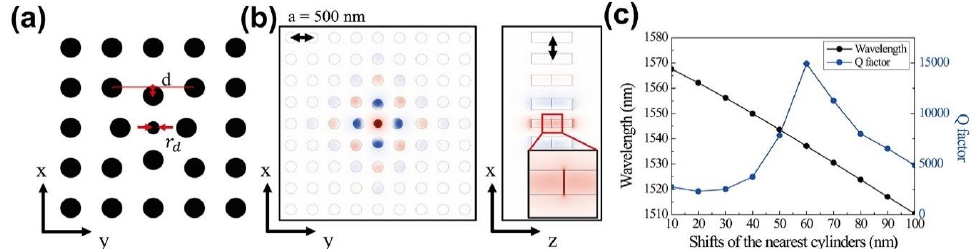
Figure 5. ( a ) Schematic of the modified cavity with a central defect cylinder and our shifted nearest neighbor cylinders. The four cylinders are shifted into the center over a distance of d; ( b ) XY and XZ mode profiles of the cavity mode when the defect cylinder radius r d = 90 nm, the shift of the four nearest cylinders d = 60 nm, and the resonant wavelength is 1537 nm. In the XZ mode profile, the inset shows the electric field confinement in the low-index SiO 2 layer of the defect cylinder; ( c ) Resonant wavelengths (black) and Q factors (blue) as functions of the shifted distance of four nearest cylinders while the center defect radius is fixed at 90 nm. The highest Q factor of 15,000 is obtained when the nearest cylinders shifted to the inner side over a distance of 60 nm.